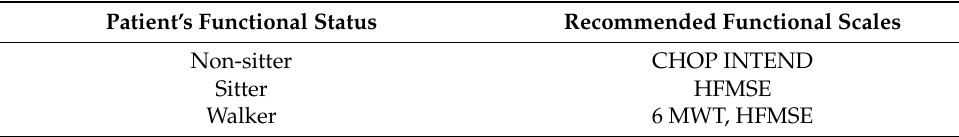
Table 1. Recommended functional scales according to patient’s functional